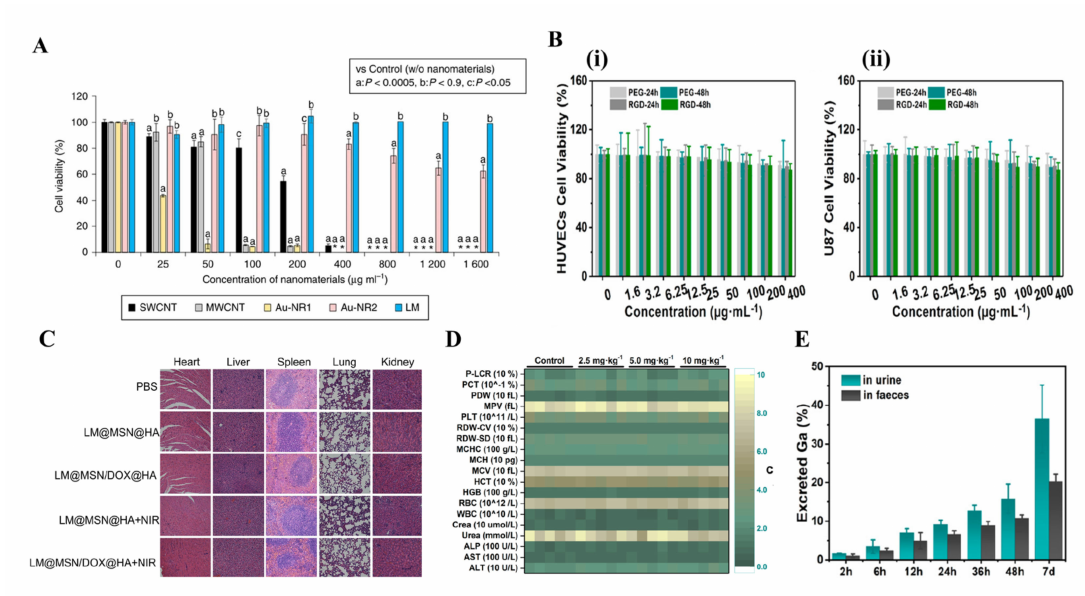
Figure 7. Biological toxicity of LMNPs. In vitro ( A ) Cell viability treated with different nanomaterials, such as single-walled carbon nanotubes (SWCNTs), multi-walled CNTs (MWCNTs), Au-NR 1 (ethyl-terminated-hydrophilic polymer conjugated gold nanorod), and Au-NR 2 (methoxy-PEG3000-SH-modified gold nanorod), LMNPs. * means: not determined because all of cells were dead [69]. ( B ) Cell viability of ( i ) normal and ( ii ) cancer cells after treatments with LMNPs coated with SiO 2 [35]. ( C ) H&E staining images of major organs with different treatment [34]. ( D ) Hematological indexes of the mice sacrificed 30 days post-injection of LMNPs coated with SiO 2 [35]. ( E ) Cumulative excretion of Ga in feces and urine